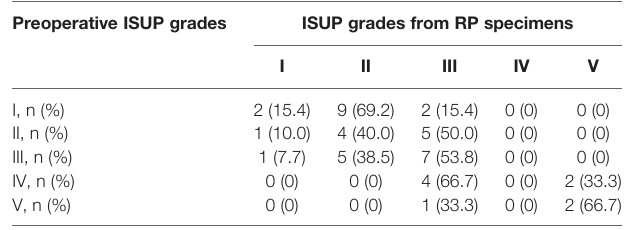
Row percentages shown in parentheses. ISUP, International Society of Urological